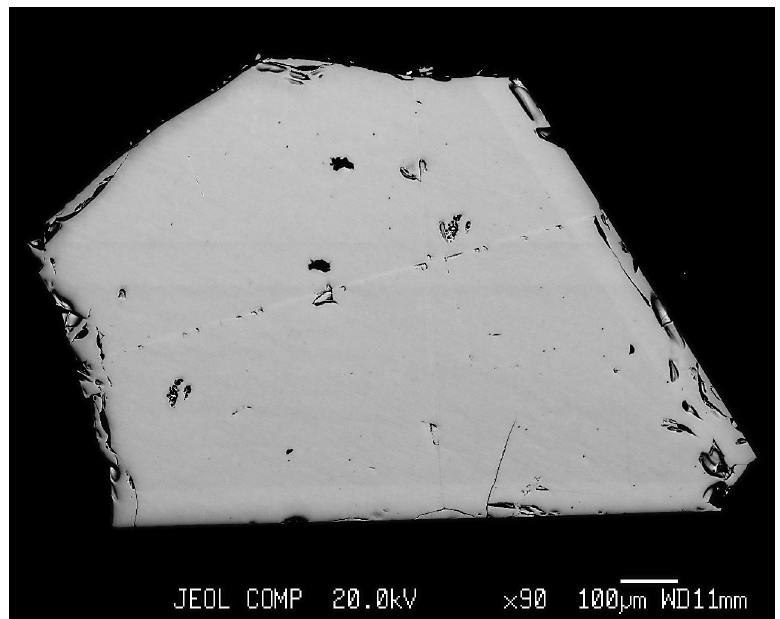
Figure 3. The scanning image in back scattered electrons (BSEs) of magnetite crystal (Experiment 8, Table 1). Note the homogeneity in elements’ distribution inside of a cry stal.